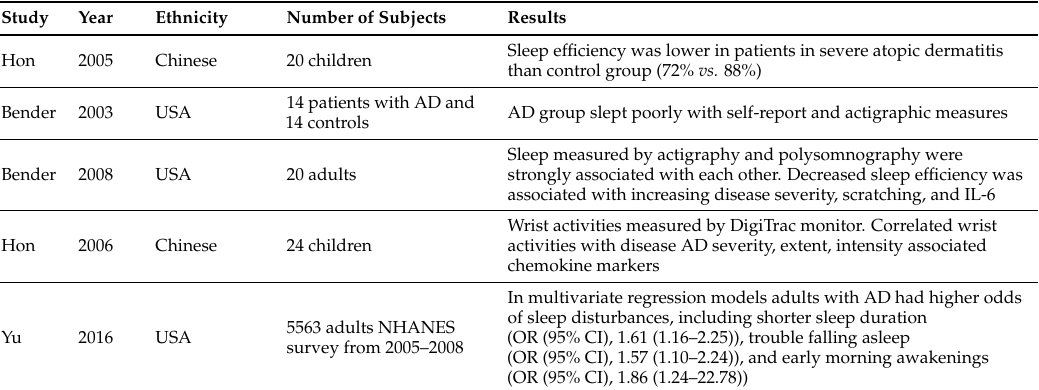
Table 1. Association of eczema and sleep